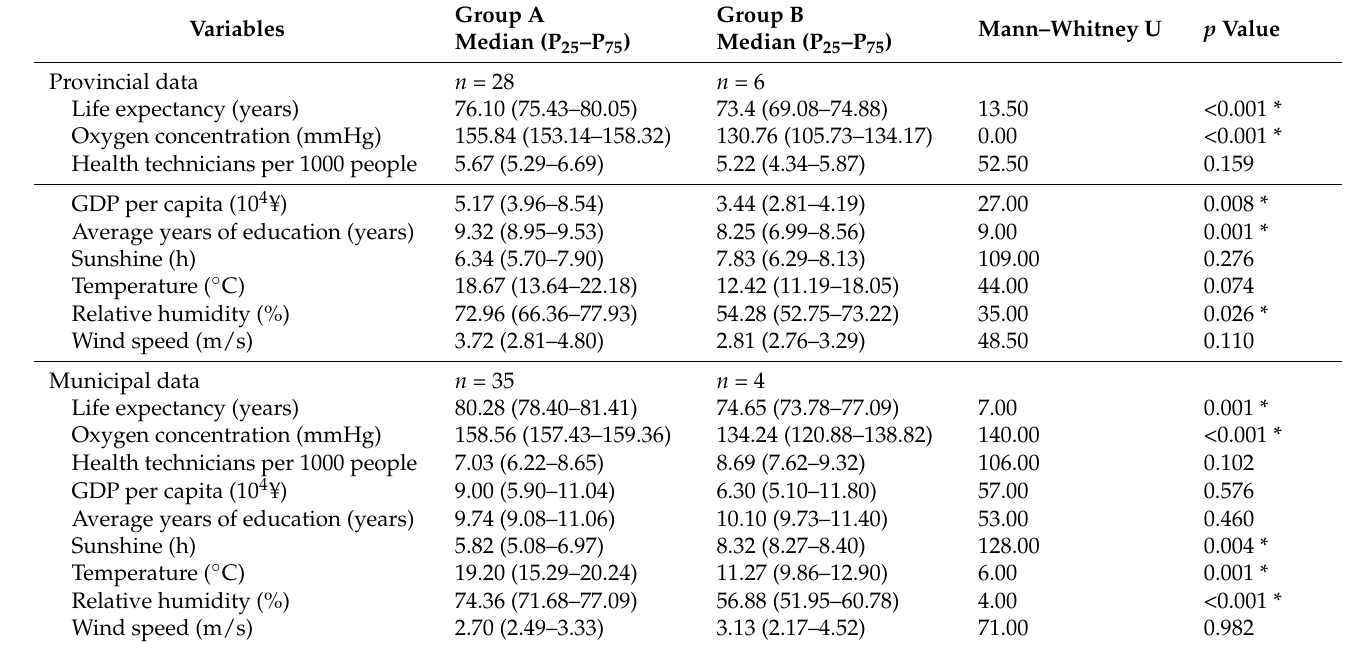
Table 1. Comparison of variables between Group A (oxygen concentration ≥ 140 mmHg) and Group B (oxygen concentration < 140 mmHg).